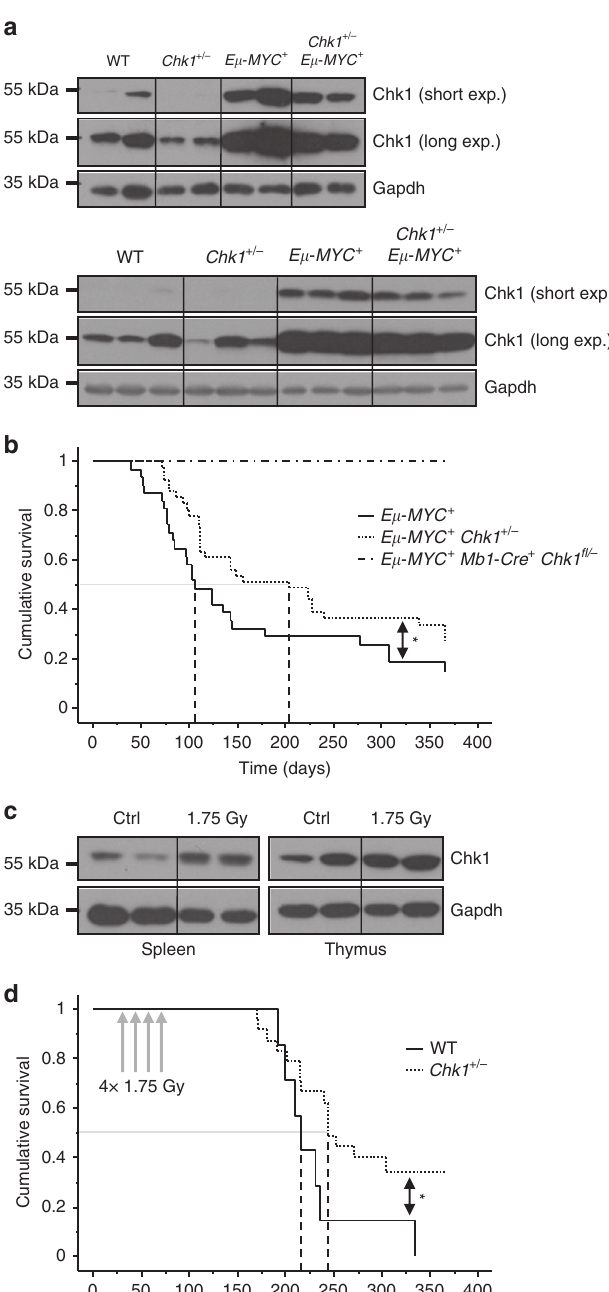
Fig. 5 Successful lymphocyte transformation depends on CHK1 expression levels. a Total splenocytes of the indicated genotypes were processed for immunoblotting using the indicated antibodies to assess the impact of MYC on CHK1 protein levels. Each lane represents an independent biological replicate. Two independent experiments are shown ( n = 5/ genotype in total) b Kaplan – Meier plot analysis showing lymphoma-free survival of mice of the indicated genotypes over an observation period of one year. E μ -MYC + n = 31, median survival 106 days, E μ -MYC + Chk1 + / − n = 41, median survival 205 days. Logrank (Mantel-Cox) p = 0.056 ( χ 2 = 3.632), Breslow – Gehan – Wilcoxon p = 0.0258 ( χ 2 = 4.967). c Wild-type C57Bl/6N mice were either left untreated or irradiated with a single dose of 1.75 Gy. Four days after irradiation organs were harvested and processed for western analysis. Each lane represents an independent biological replicate. d Kaplan – Meier analysis showing lymphoma-free survival of WT and Chk1 + / − mice exposed to a fractionated irradiation protocol (4× 1.75 Gy) at 4 weeks of age. Median tumor onset: WT ( n = 7) 217 days, Chk1 + / − ( n = 24) 245 days. Logrank (Mantel-Cox) p = 0.0399 ( χ 2 =